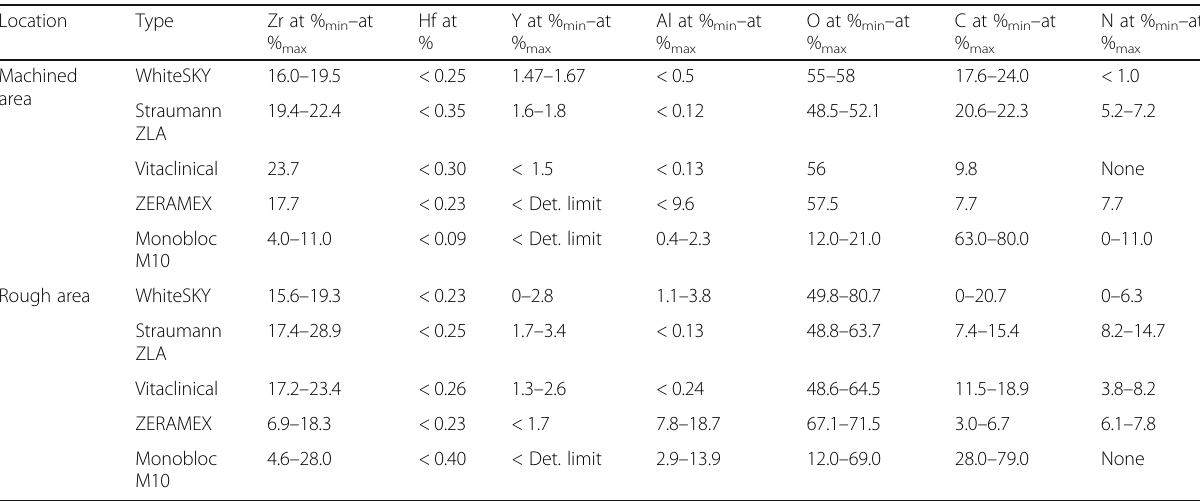
Element composition/semi-quantitative